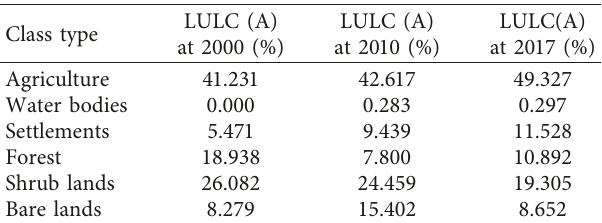
Figure 3: Land use and land cover maps of 2000 and 2010. Table 2: LULC class distributions and changes of 2000, 2010, and